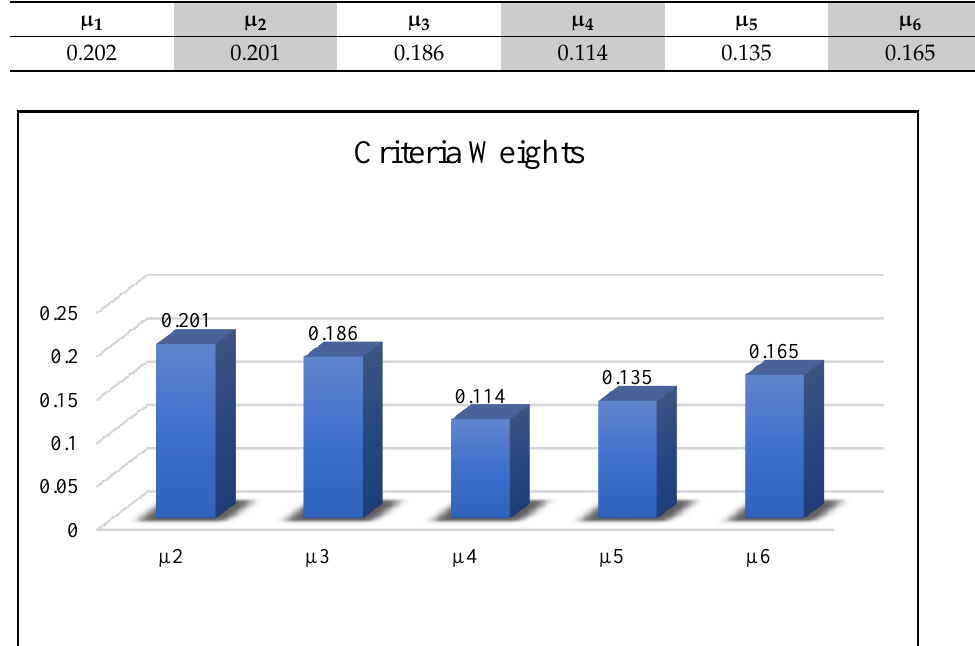
Figure 1. Criteria weights.